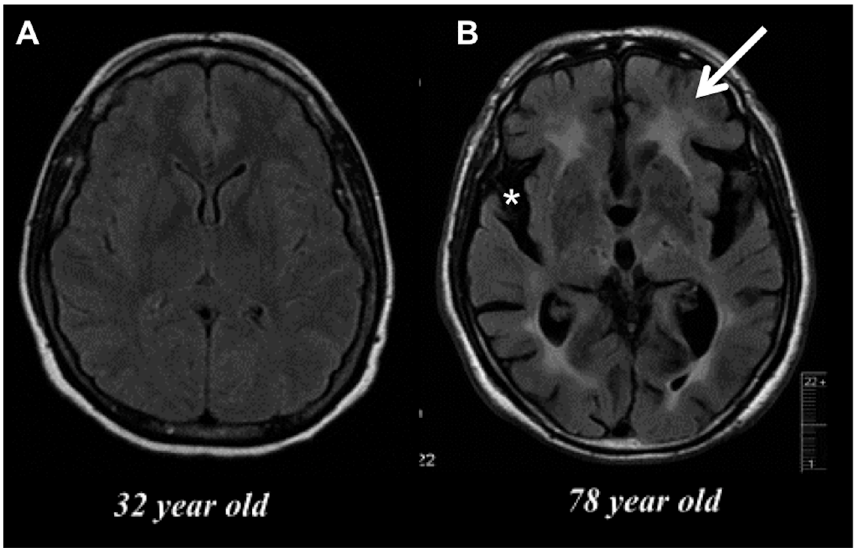
Figure 2. ( A ) Magnetic resonance imaging (MRI) of a normal 32 year old woman. There is no evidence of atrophy or white matter disease; ( B ) MRI of a 78 year old woman with mild cognitive impairment. There is considerable frontal temporal atrophy as seen by an enlarged Sylvian fissure (asterisks) and white matter disease (white arrow).